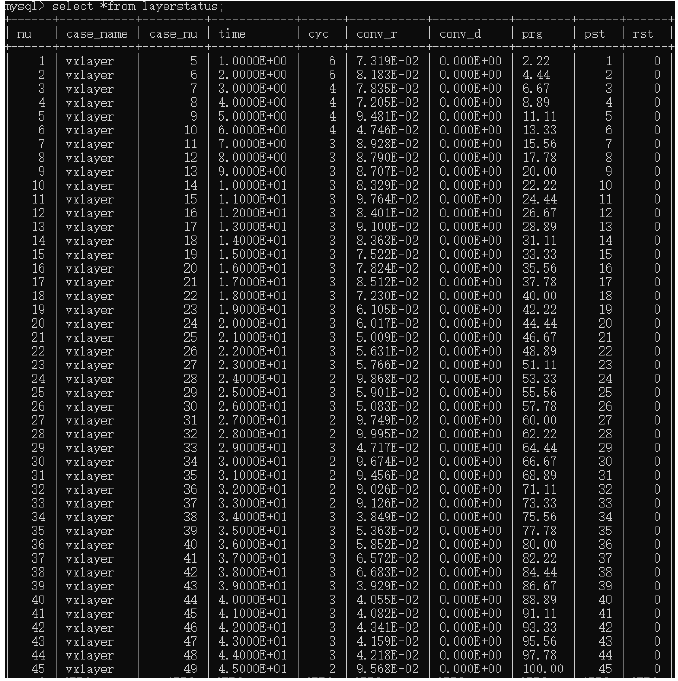
Fig. 11 The database table